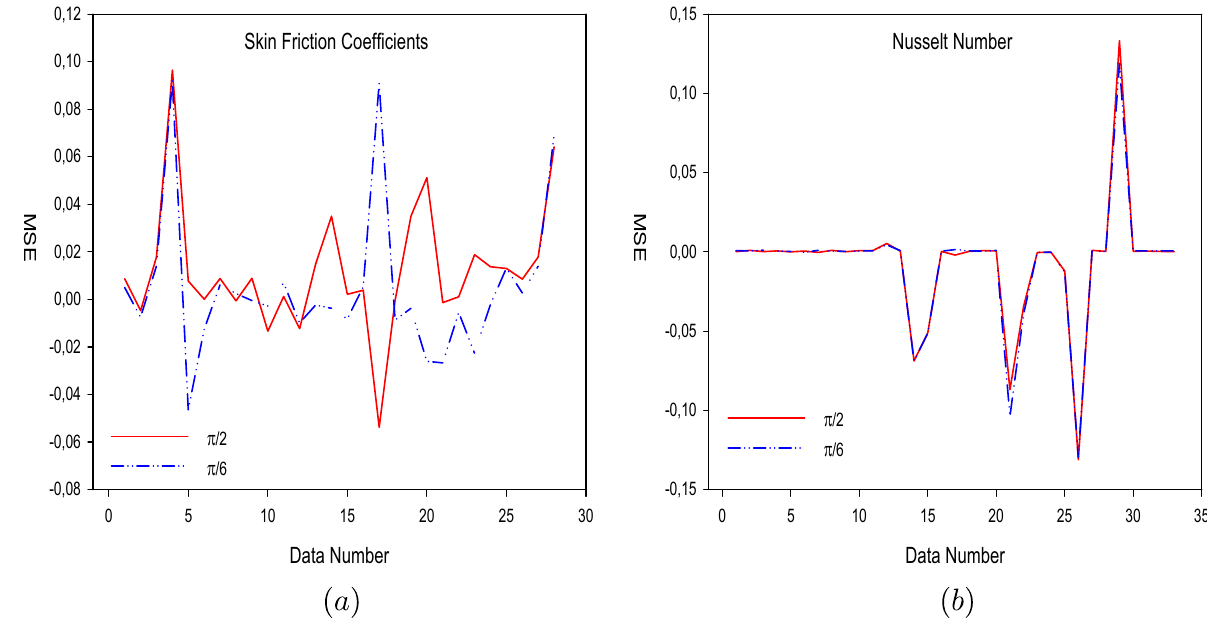
Figure 20. MSE values ( a ) Skin Friction Coefficients ( b ) Nusselt Number.